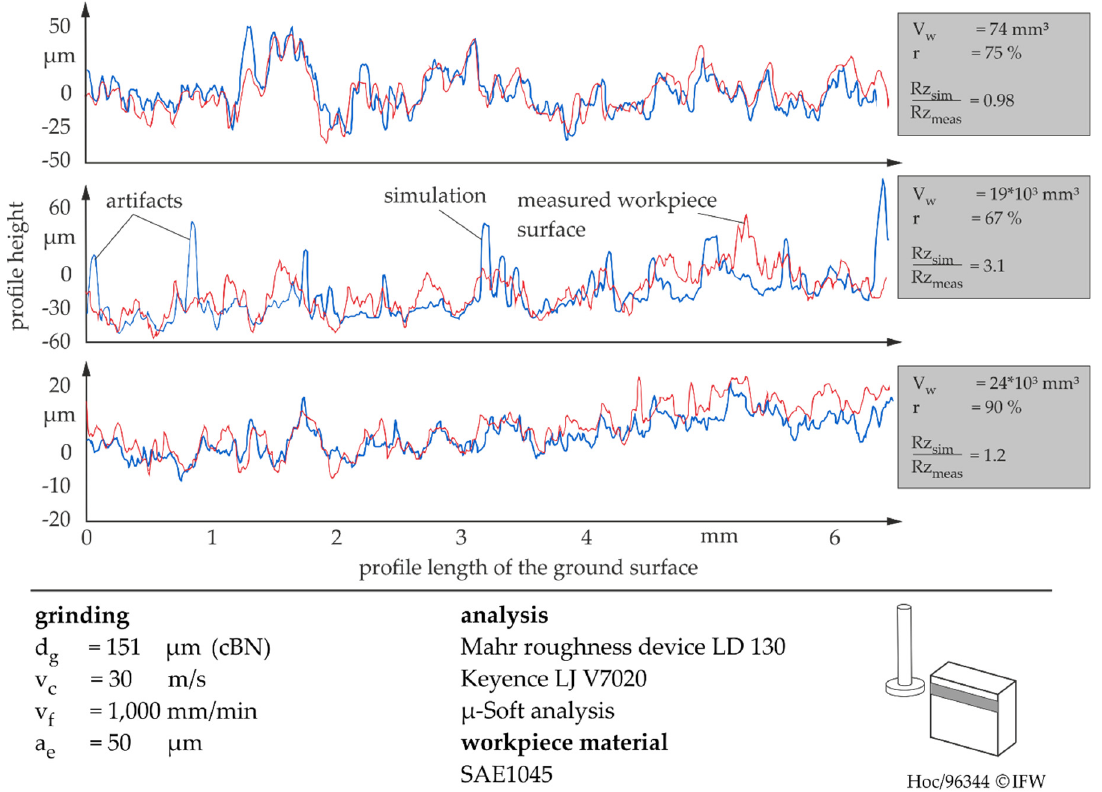
Figure 7. Examples of comparison between simulated and measured workpiece topography.